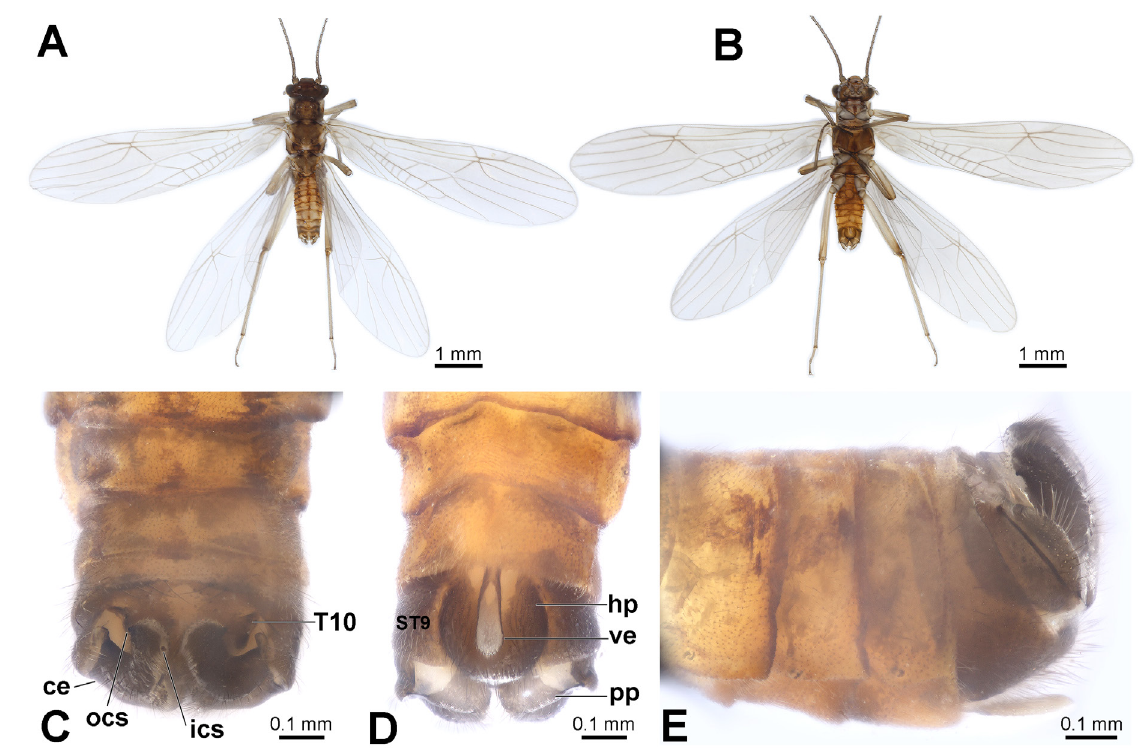
Fig. 2. Nemoura lixiana sp. nov. A . Male habitus, dorsal view. B . Male habitus, ventral view. C . Male terminalia before NaOH treatment, dorsal view. D . Male terminalia before NaOH treatment, ventral view. E . Male terminalia before NaOH treatment, lateral